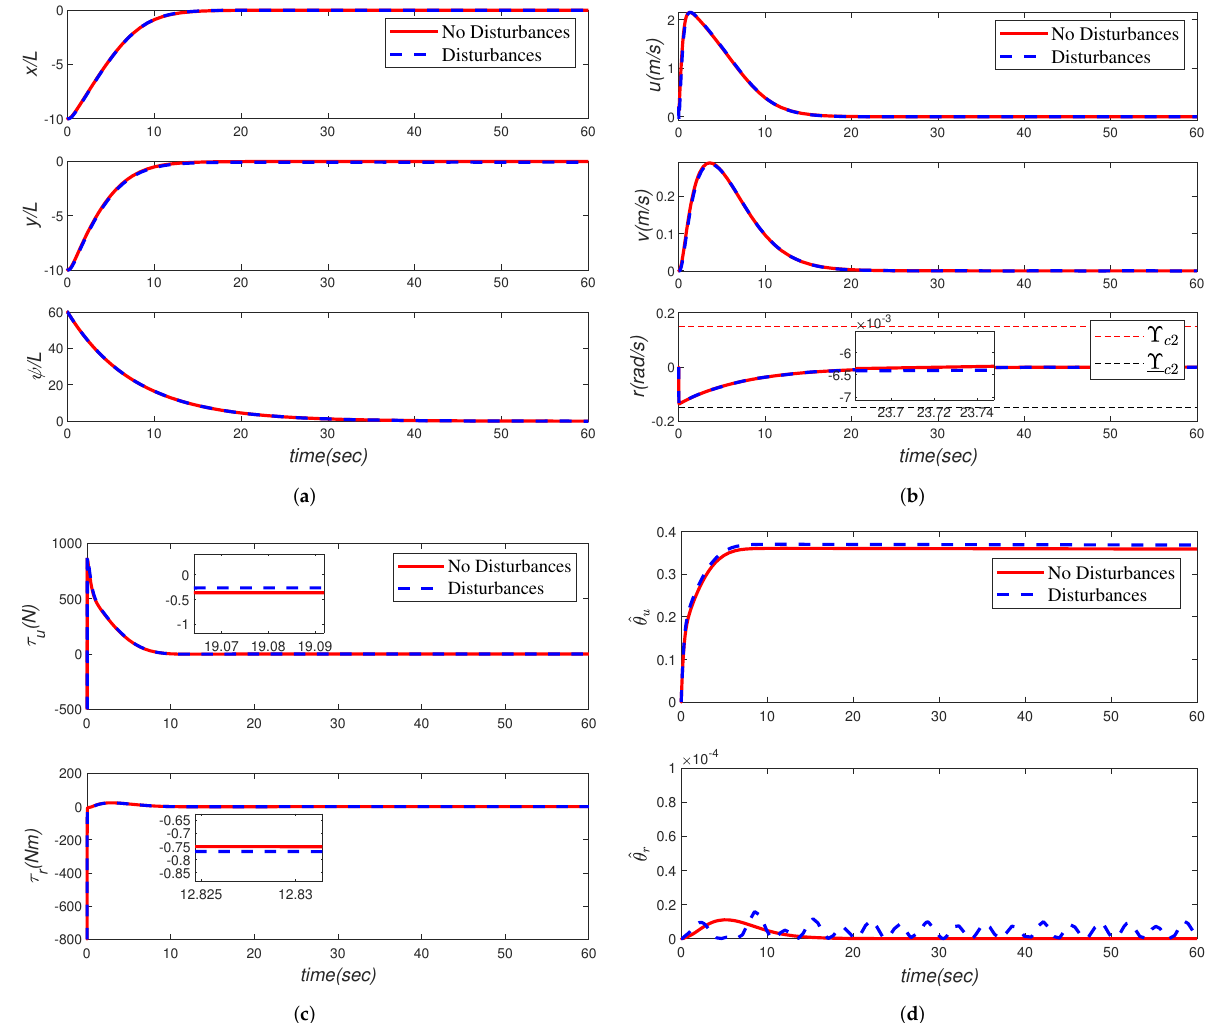
Figure 5. Comparisons of control scheme Equation (49) under interference and no